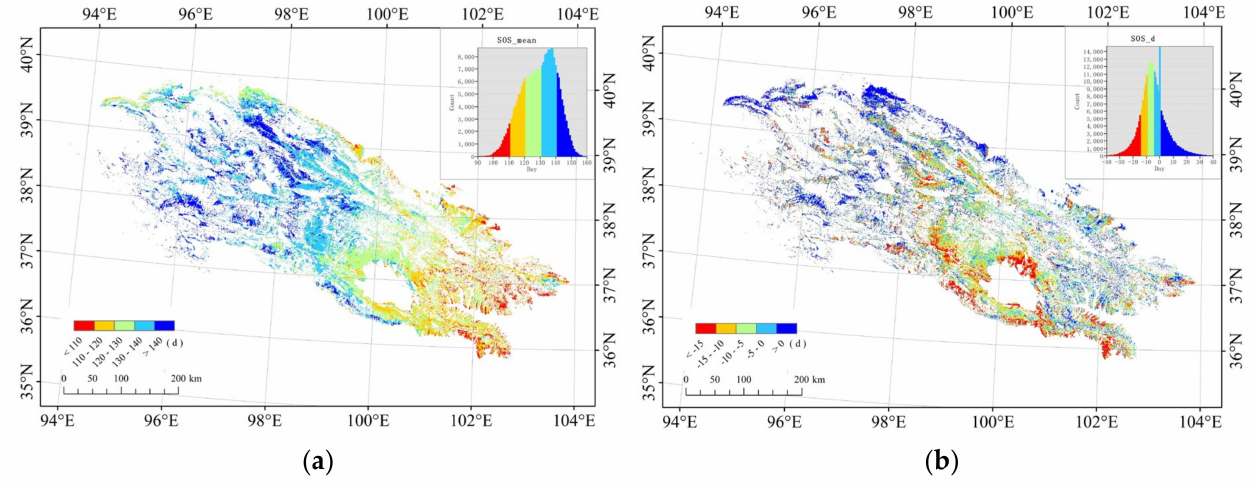
Figure 8. Spatial distribution of ( a ) average SOS for 20 years from 2000 to 2019 and ( b ) difference in SOS for 20 years by linear regression from 2000 to